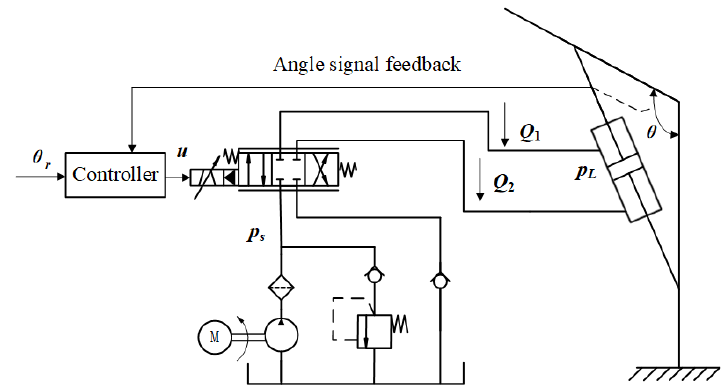
Figure 3. Control diagram of hydraulic manipulator system .